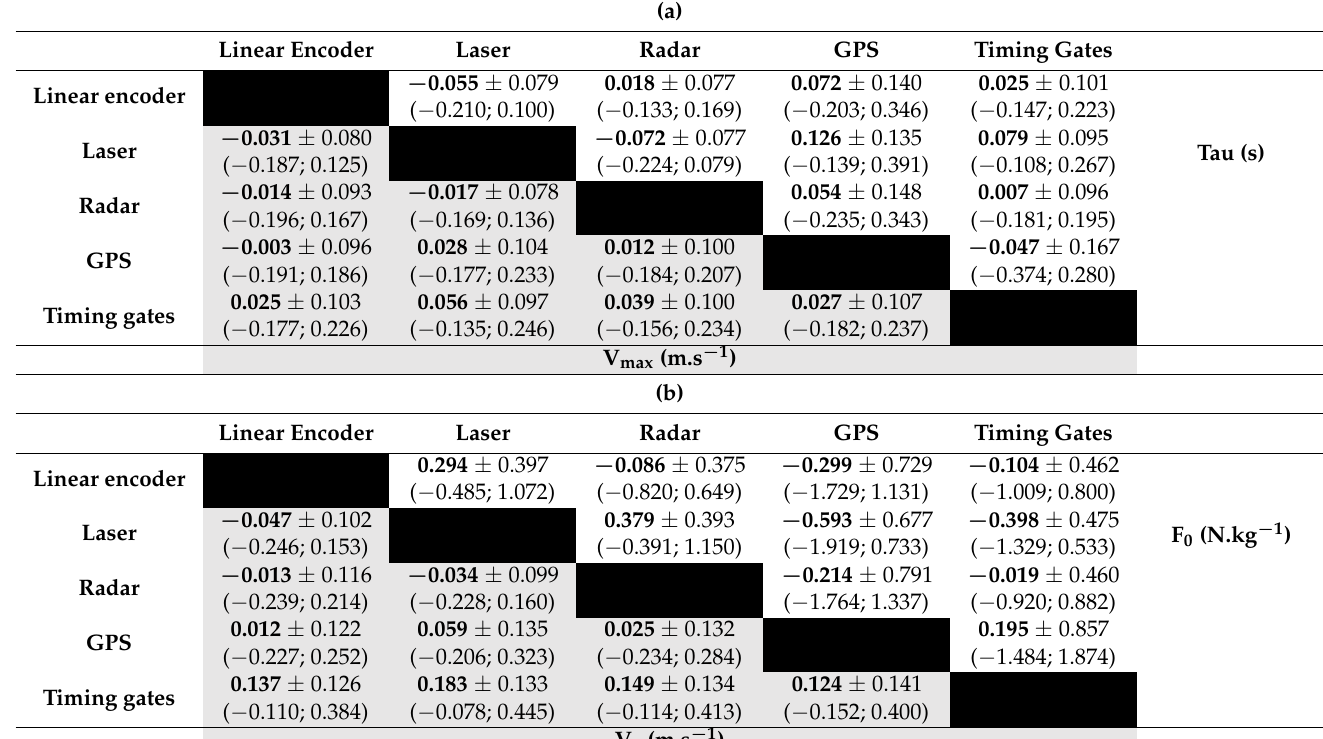
− 0.014 ± 0.093 − 0.017 ± 0.078 Radar